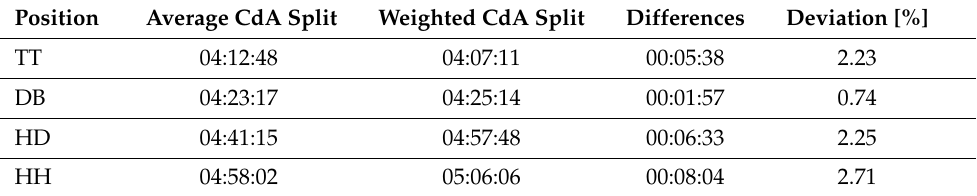
Table 4. Bike split prediction for weighted and averaged CdA model; time in hh:mm:ss. Position Average CdA Split Weighted CdA